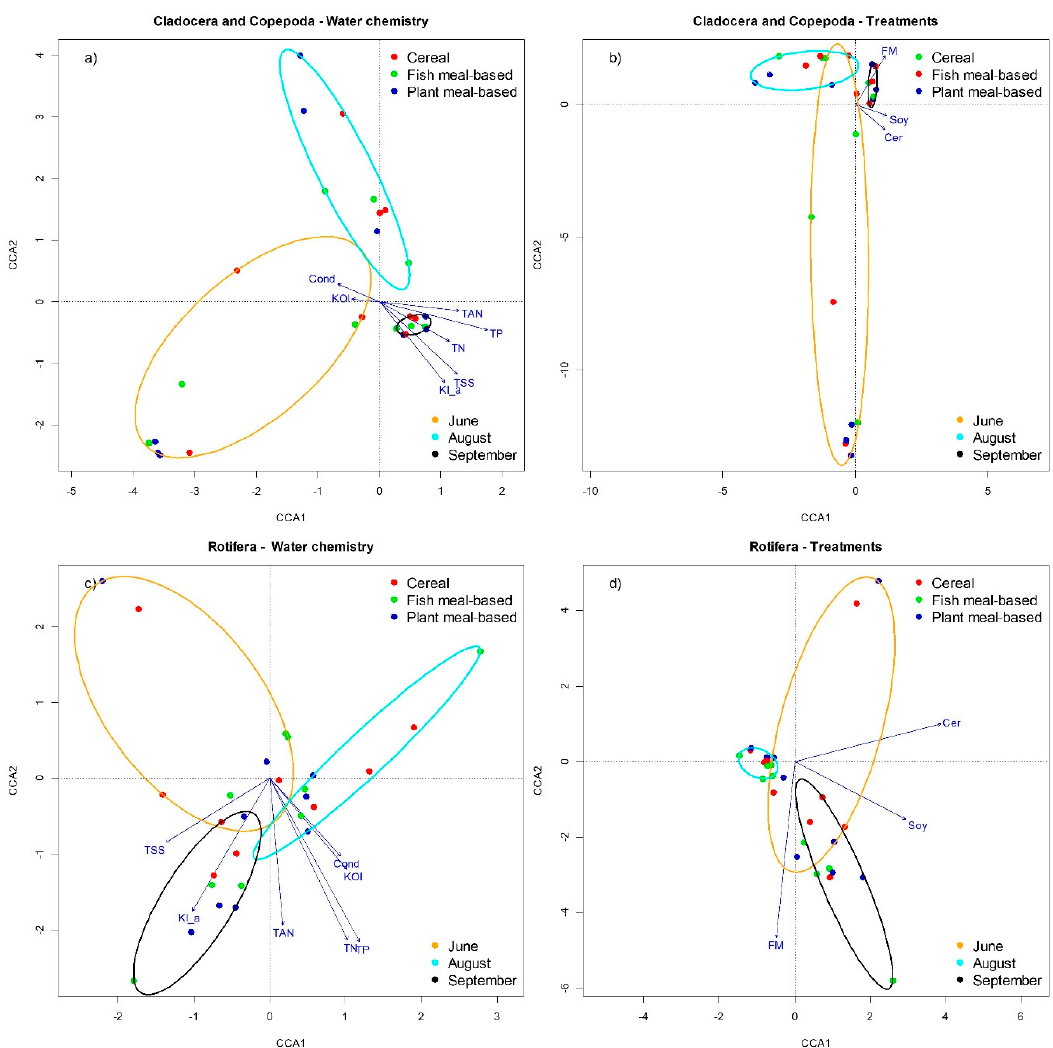
Figure 5. Canonical Correspondence Analysis (CCA) results of the effect of water chemistry and feed ingredient parameters on the distribution of rotifera and Crustacean (cladocera and copepoda) communities. Abbreviations of water chemistry parameters (a–c): TN—Total nitrogen; TAN—